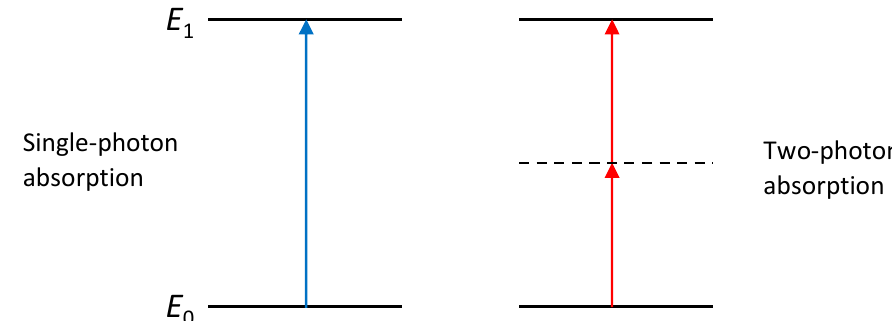
Figure 2. Energy level schematic for single photon absorption and two-photon absorption processes. Dotted line indicates imaginary intermediary state.